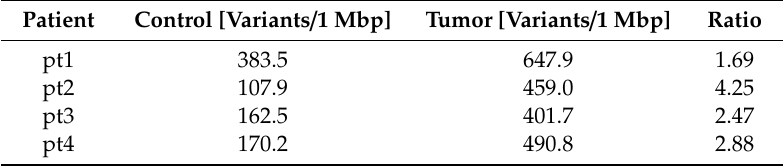
Table 4. Tumor mutation burden of WES-sequenced patients´ primary TGCT samples.